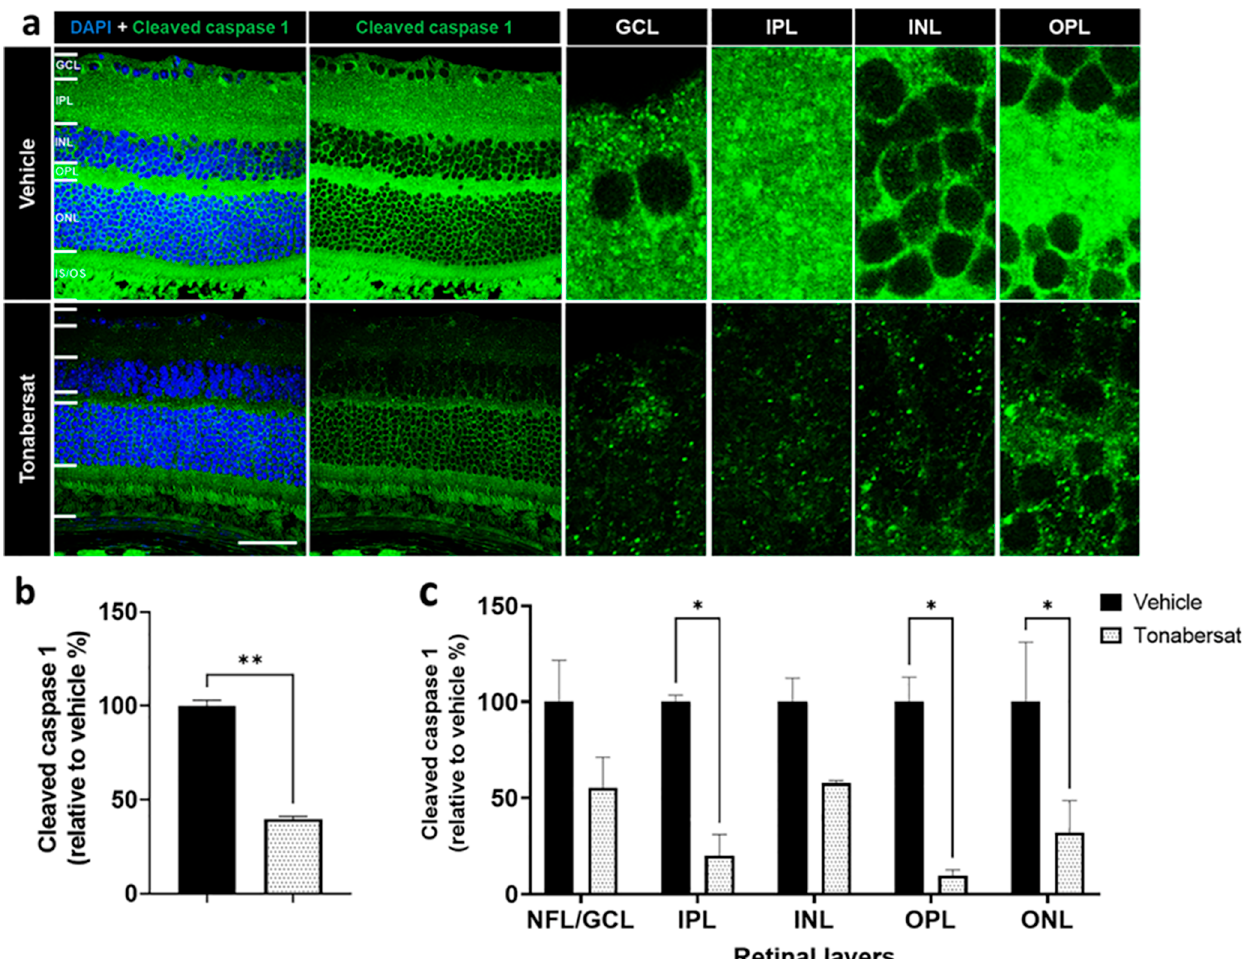
Figure 7. ( a ) Cleaved caspase-1 expression was evident in both groups though overall levels appeared lower following tonabersat treatment compared to the vehicle group. GCL = ganglion cell layer; IPL = inner plexiform layer; INL = inner nuclear layer; OPL = outer plexiform layer; ONL = outer nuclear layer; IS/OS = inner and outer segments. Scale bar = 50 µm. ( b ) Tonabersat treatment significantly decreased overall cleaved caspase-1 levels relative to the vehicle group. Statistical anal- yses were carried out using Student’s t-test. ( c ) Quantification of cleaved caspase-1 levels, another marker of inflammasome complex assembly, within specific retinal layers suggests that tonabersat treatment significantly reduced cleaved caspase-1 levels within the IPL, OPL, and ONL. Data are presented as a mean + SEM. Statistical analyses were carried out using two-way ANOVA with Sidak’s multiple comparison’s test. * p ≤ 0.05, ** p ≤ 0.01. n = 8–12 eyes per group.